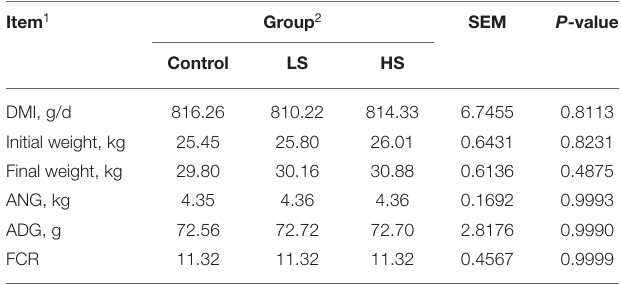
TABLE 2 | Effect of purple corn pigment on DMI and growth performance of goats.